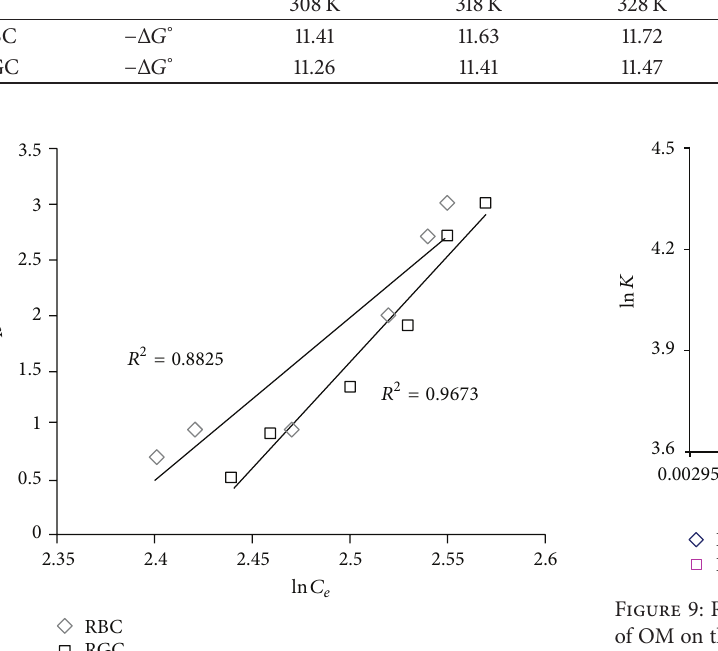
= 200 r/min; 𝐶 = 491 ppm; 0 Speed